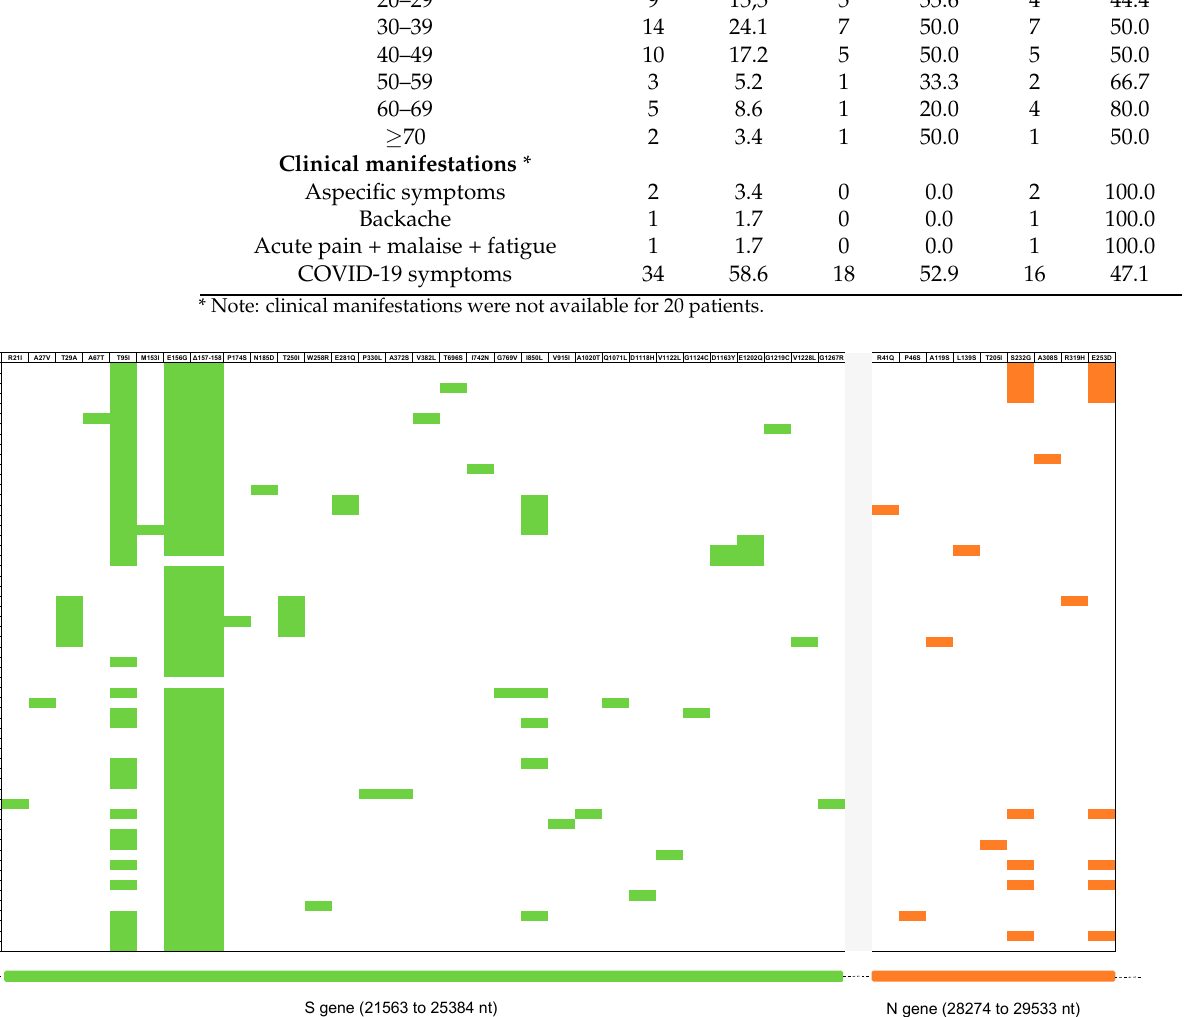
Figure 1. Heatmap of S (light green) and N (orange) amino acid substitutions detected in each isolate. The appearance of substitutions was organized based on their inclusion in a cluster (colored box) or not (white box) by phylogenetic analysis. Nucleotide (nt) position of sequenced genes is reported in the lower part of the figure.